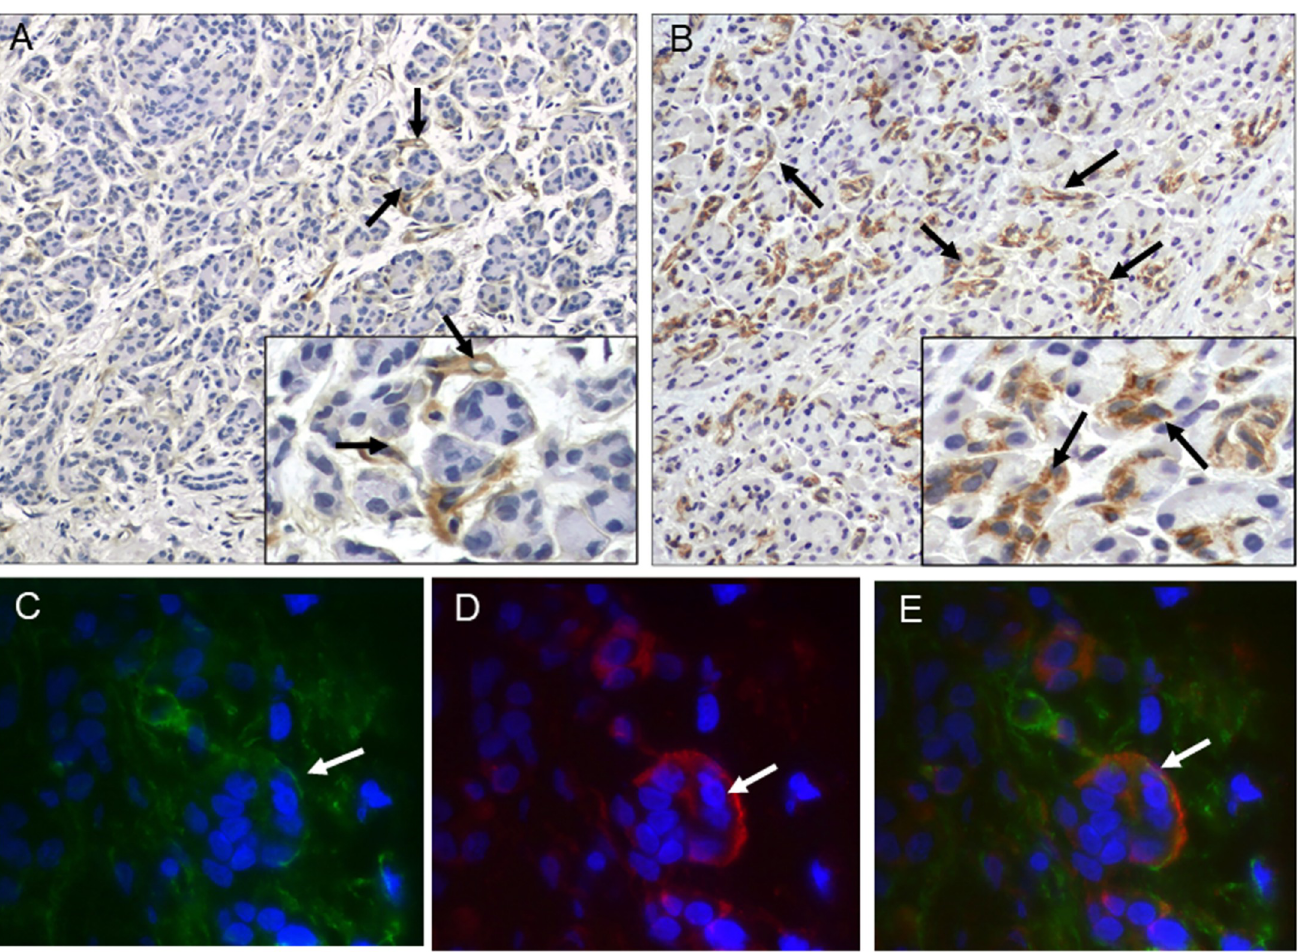
Fig 2. RNLS is present in spindle-shaped cells in human chronic pancreatitis. Representative images of RNLS immunoreactivity using the m28-RNLS antibody in (A) genetic chronic pancreatitis (CTRC mutation) and (B) PDAC-associated chronic pancreatitis. (C-E) Immunofluorescence labeling of RNLS with m28-RNLS antibody (green) and alpha-smooth muscle actin (red) in a patient with genetic chronic pancreatitis (CTRC mutation). The white arrows point to cells positive for both proteins (stellate cells). Original magnification A and B: 200x, insets 400x. Original magnification C-E: 10000x.